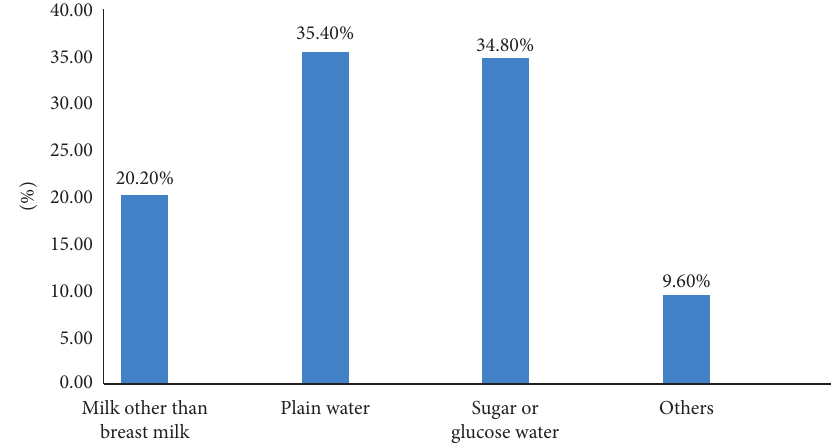
Figure 3: Type of prelacteal feeding given to infants by mothers in the rural eastern zone, Tigray, Ethiopia, 2018. Table 3: Factors associated with the prelacteal feeding practice among mothers with children aged less than 12months in the rural eastern Tigray, Ethiopia,